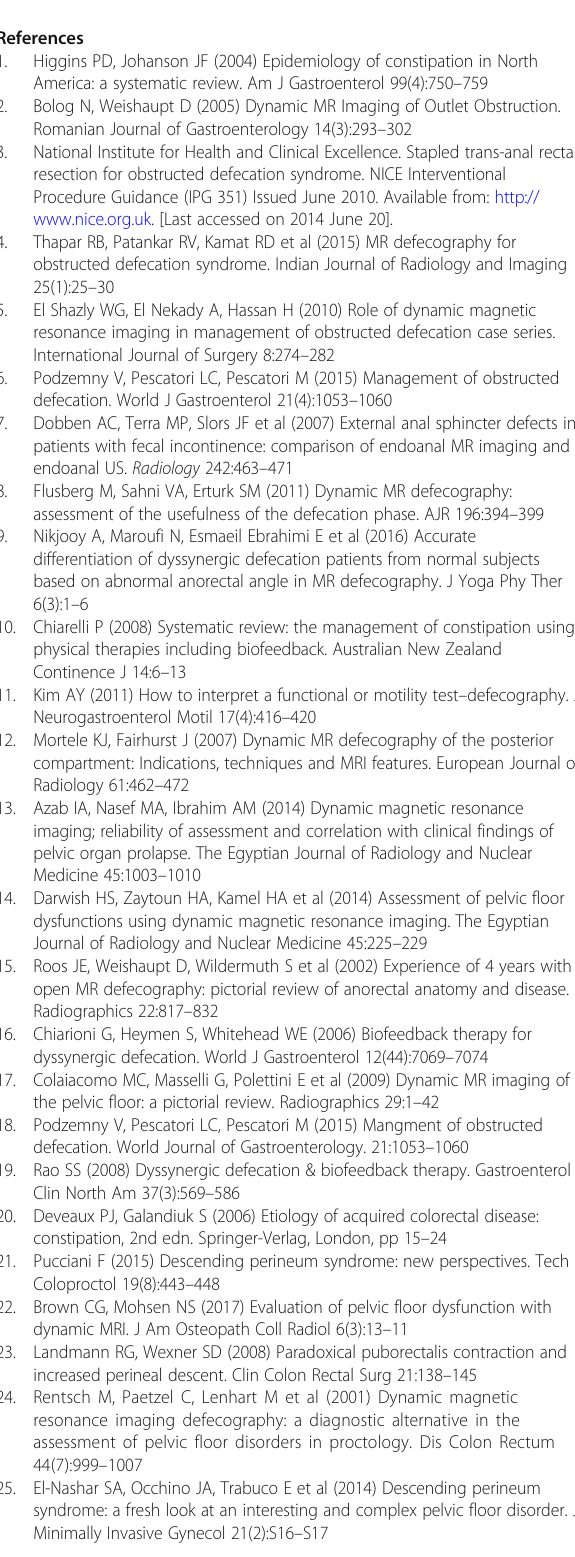
Table 4 Number of pelvic compartment affected by MRD No. of compartment